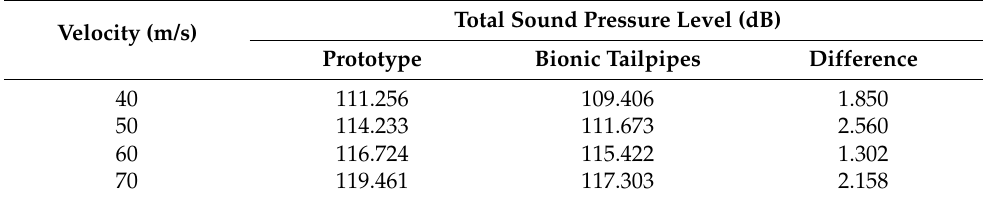
Figure 7. Sound pressure level frequency response curve of prototype and bionic exhaust tailpipe at different airflow velocities: ( a ) at 40 m/s, ( b ) at 50 m/s, ( c ) at 60 m/s, ( d ) at 70 m/s. Table 2. Total sound pressure level between 10 Hz and 2500